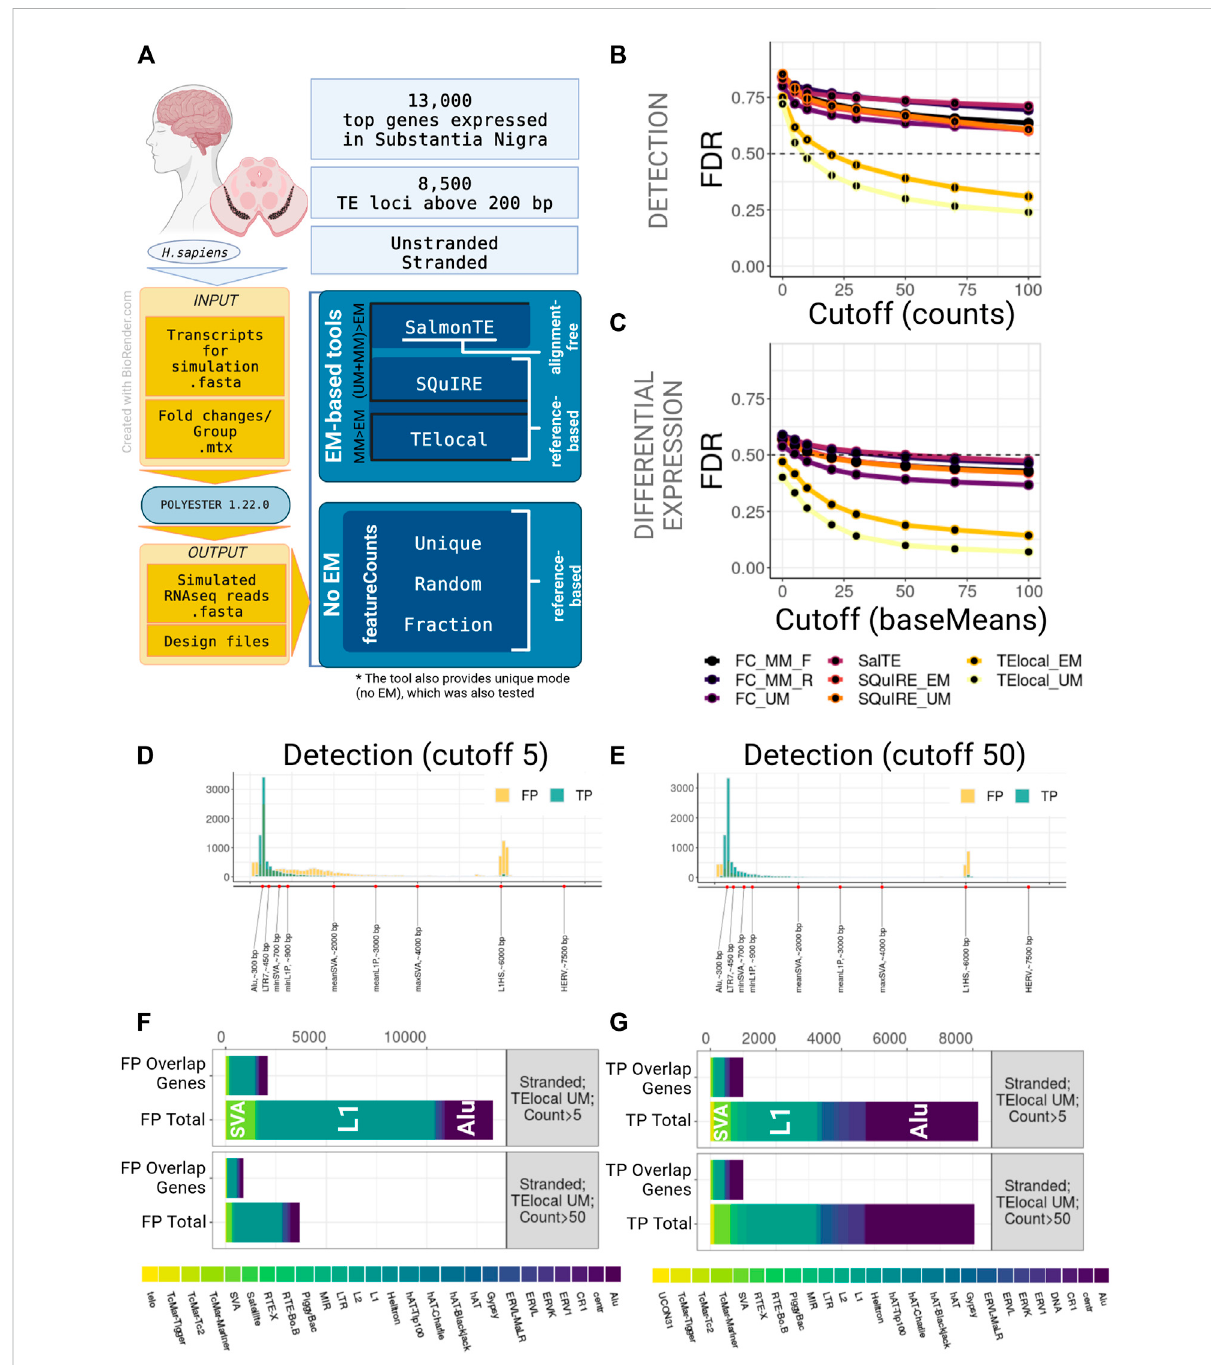
FIGURE 1 Benchmarking of TE quanti fi cation tools on human model, stranded experiment. (A) A general overview of the simulation setup and the strategies used in benchmarking. For human simulation 2,000 TEs over 200 bp long and top 13,000 genes expressed in substantia nigra were simulatedinstrandedandunstrandedexperimentsusingPolyester1.22.0.Theresultingsimulatedsequencingdatawasprocessedusing3EM-based tools (both in EM and no EM modes, where permissible) and 3 modes of featureCounts. (B) TE Detection FDR for different detection cutoffs using the tested tools. TElocal in unique mode (TElocal_UM) outperformed other strategies closely followed by TElocal in EM mode (TElocal_MM), however even with higher cutoffs FDR reached 26%. (C) TE Differential Expression detection FDR for different expression cutoffs. (D,E) Length distributionofTruePositive(TP)andFalsePositive(FP)hitsforTElocalinUMmodeatdetectioncutoff5 (D) and50 (E) . (F) FamilyCompositionoftotal FP hits (Total) and FP hits overlapping the simulated expressed genes (Overlap Genes) for TElocal_UM at detection cutoffs 5 and 50. Only a minority of the FPs at both cutoffs can be explained by misattribution of the genic reads (2091/13301 for cutoff = 5 and 887/3705 for cutoff = 50). (G) Family Composition of TP hits categorized by total and overlap genes. FC_MM_F, featureCounts using multimappers in “ fraction ” mode; FC_MM_R, featureCountsusing multimappersin “ random ” mode;FC_UM, featureCountsusing unique mappers only;SalTE, SalmonTE; SQuIRE_EM, SQuIRE in EM mode; SQuIRE_UM, SQuIRE in unique mode; TElocl_EM, TElocal in EM mode; TElocal_UM, TElocal in unique